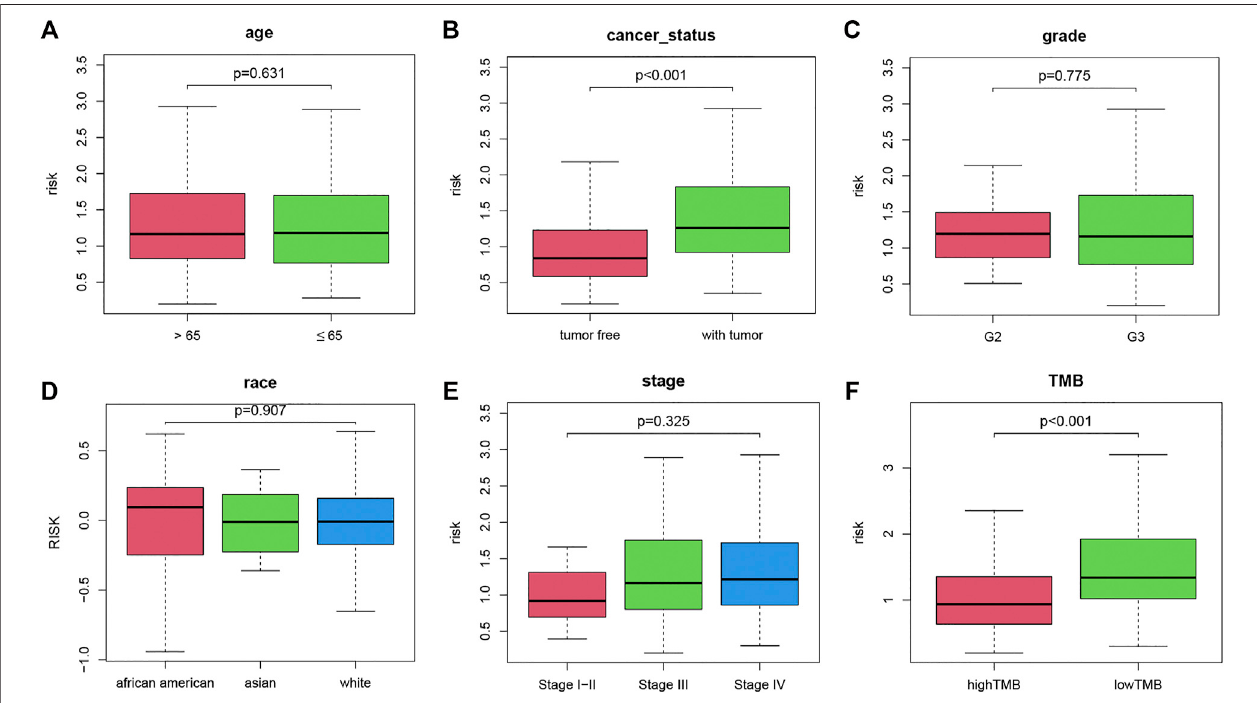
FIGURE 3 | Boxplot of the relationship between clinicopathological factors and TMB-IRS. (A – F) Relationship between age, tumor status, grade, race, stage, TMB and TMB-IRS, respectively.